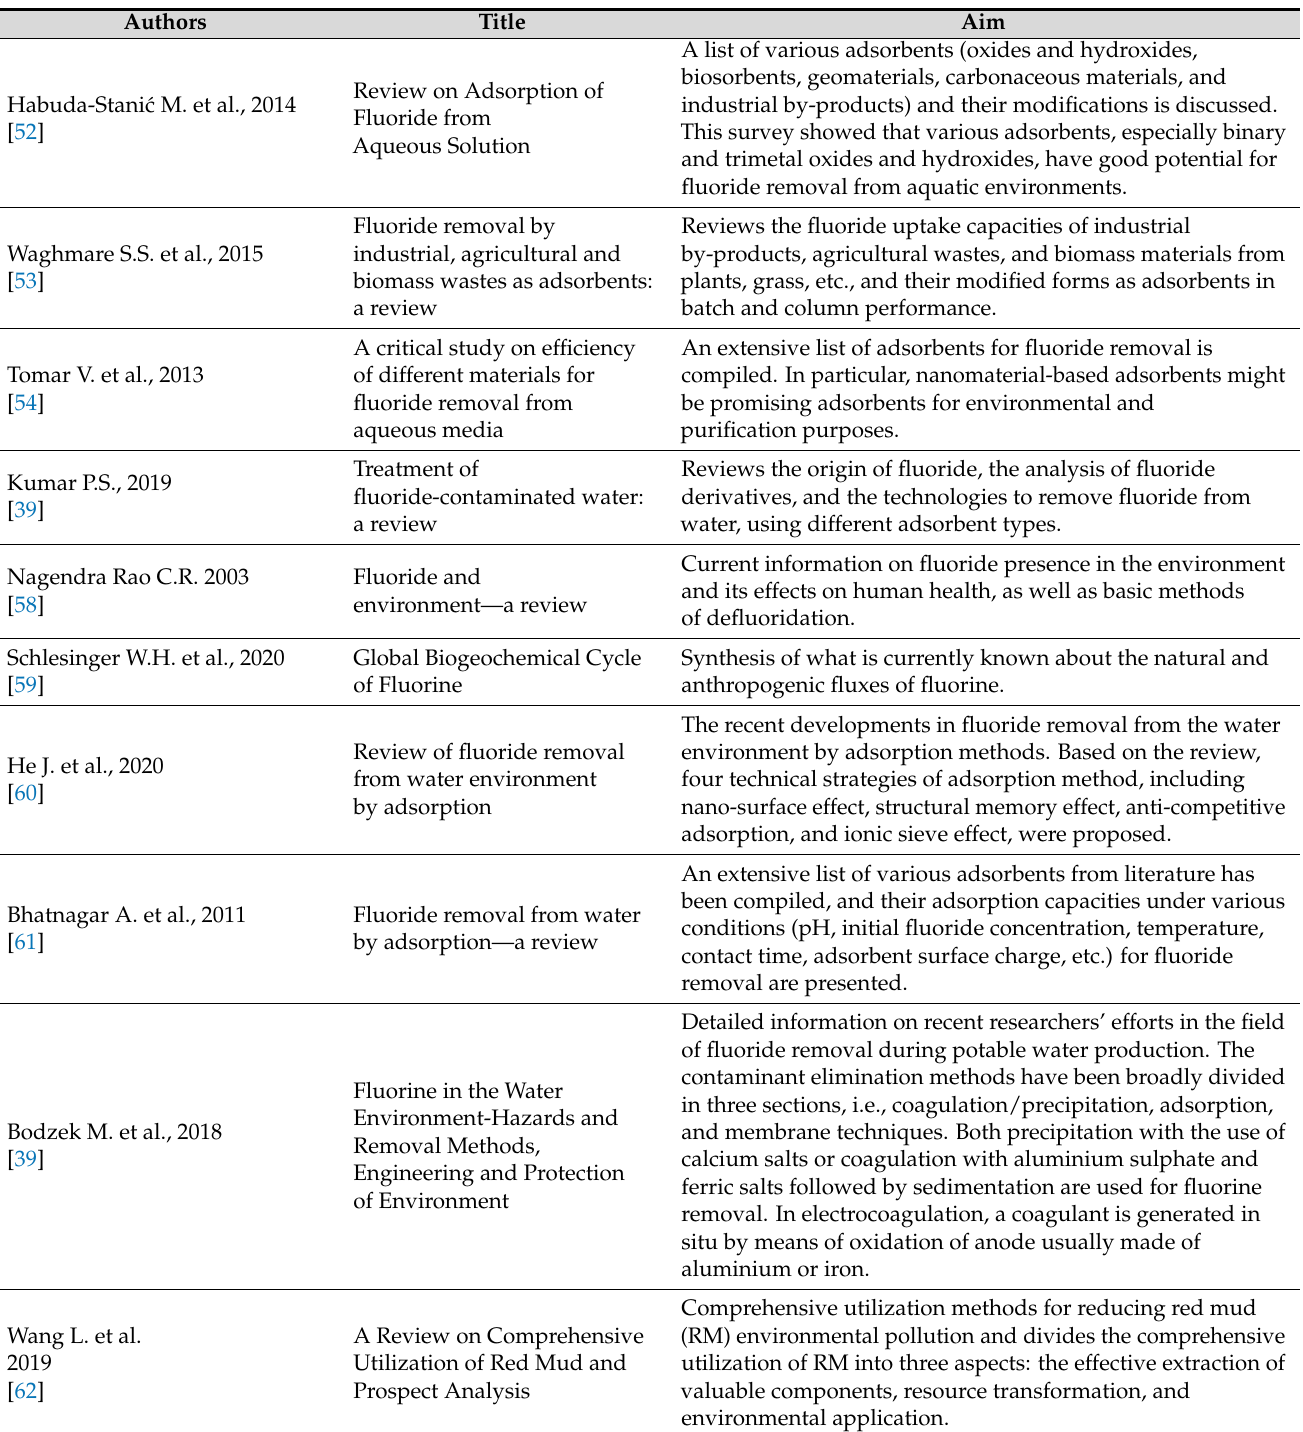
Table 1. A summary of review publications that have been published over the past decade on the removal of fluoride from drinking water and industrial